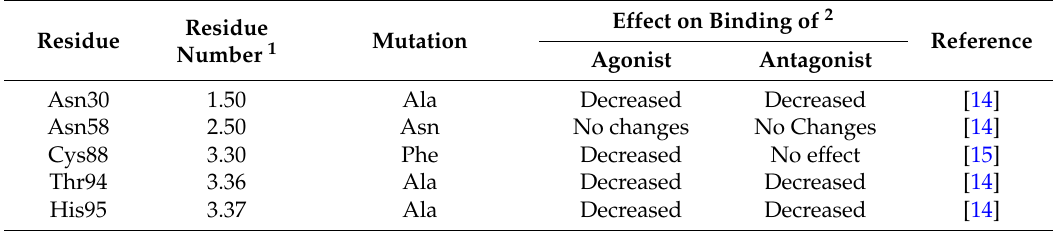
Table 1. Summary of Site-Directed Mutagenesis Analyses at the hA 3